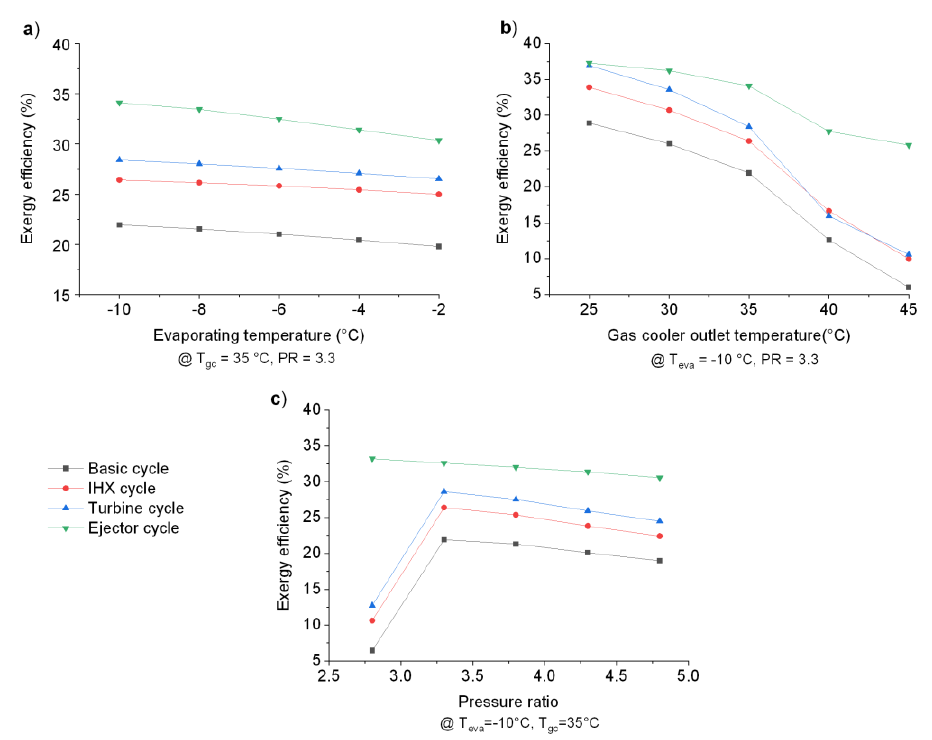
Figure 5. Variations in exergy efficiency due to the: ( a ) evaporating temperature; ( b ) gas cooler outlet temperature; ( c ) pressure ratio.